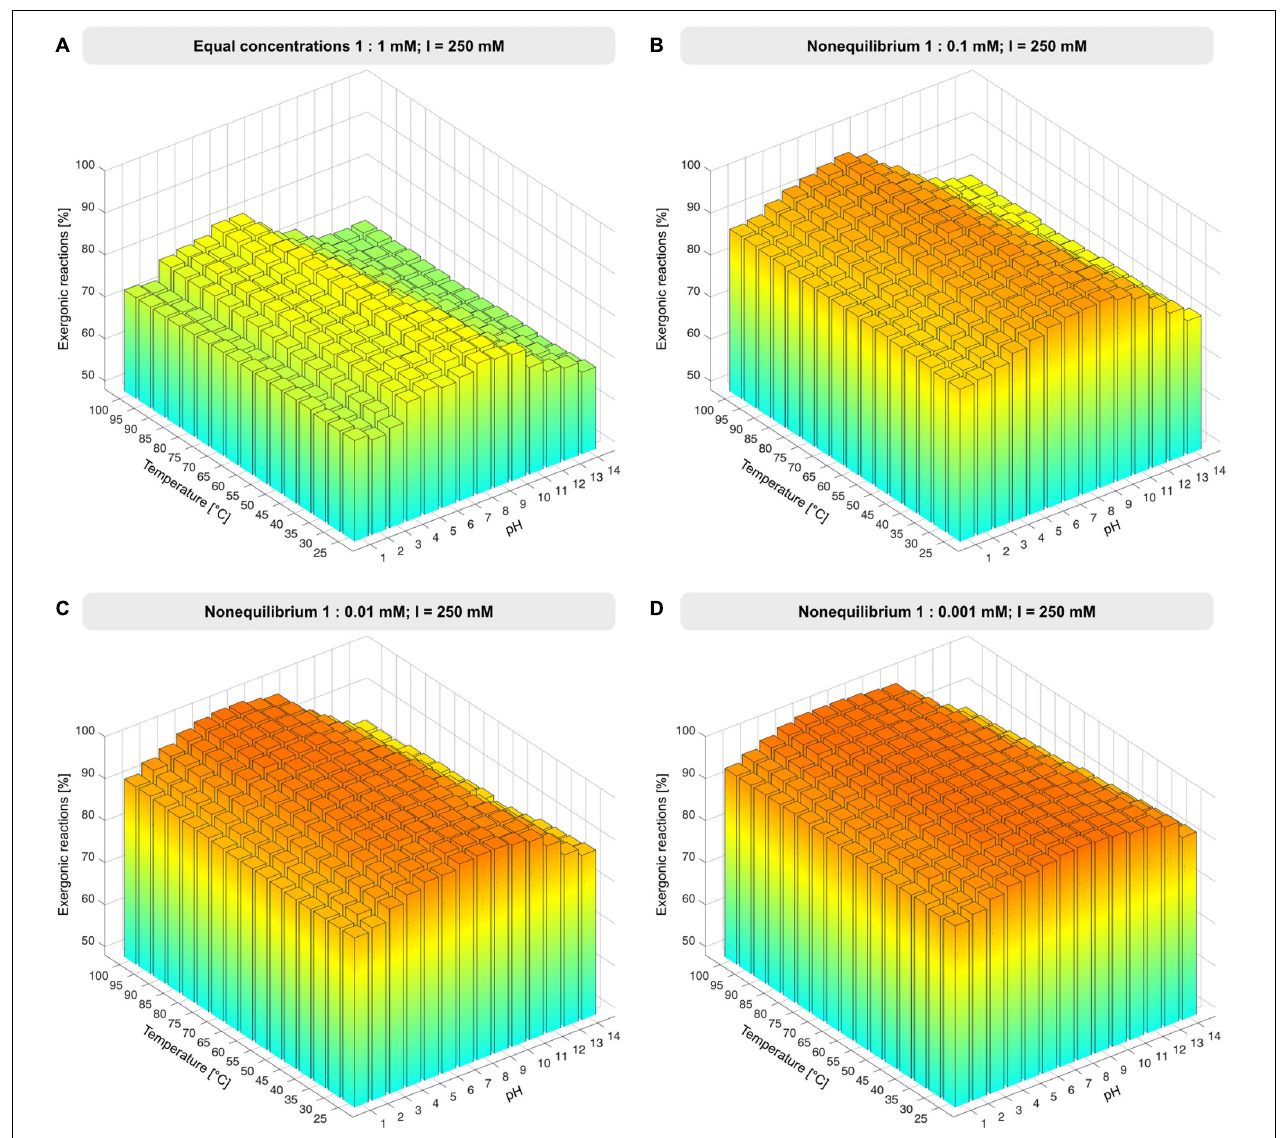
FIGURE 2 | Proportion of exergonic reactions under nonequilibrium conditions. (A) At constant ionic strength, I, and reactant concentration of 1 mM, the concentration of products was decreased from 1 mM to 1 µ M (B–D) , (cid:49) G was calculated for the 351 reactions that deliver a value of (cid:49) G across the pH and temperature range and the proportion of exergonic reactions was plotted for each condition set (see also Supplementary Figure 1 and Supplementary Table 3 ).